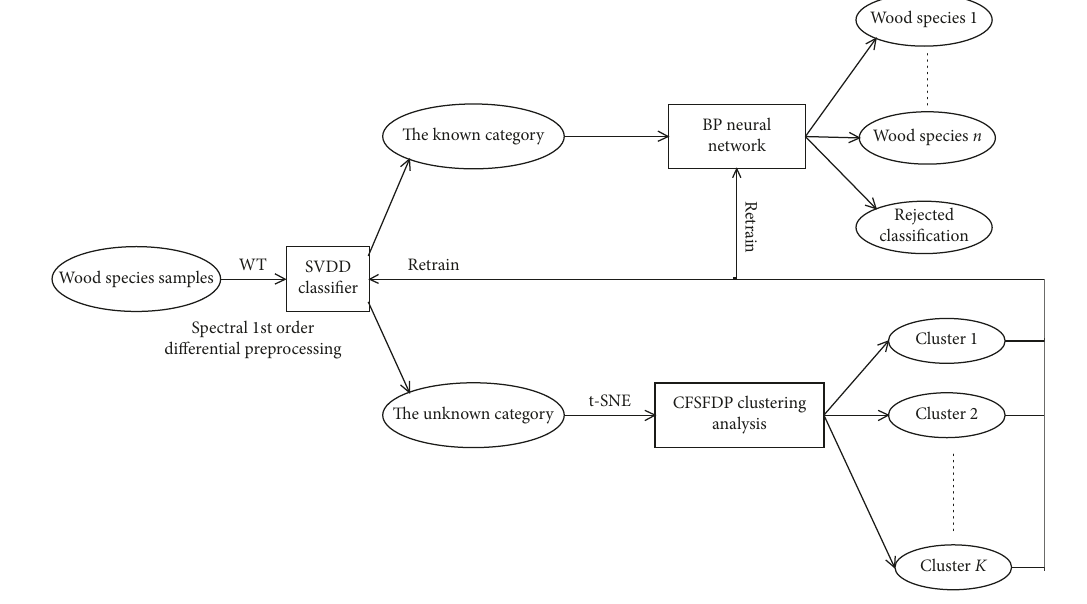
Figure 1: Our prototype system’s structure graph. Table 1: Wood species